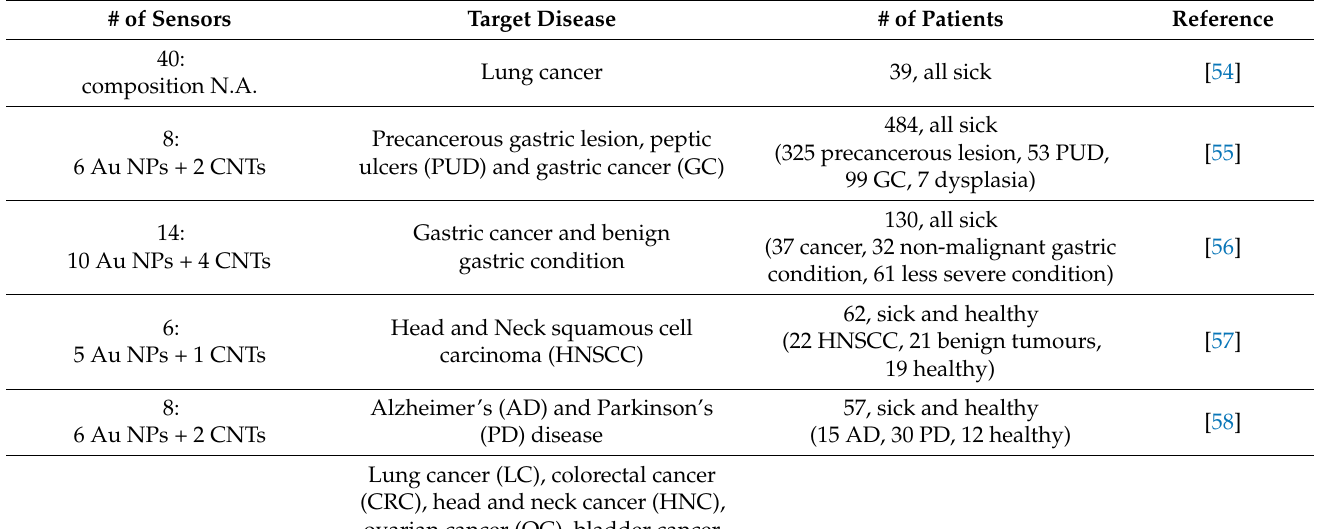
Table 5. Number of the sensors in the electronic nose based on NPs and CNTs, the target disease, and the number of patients tested. # = number, N.A. = not available.